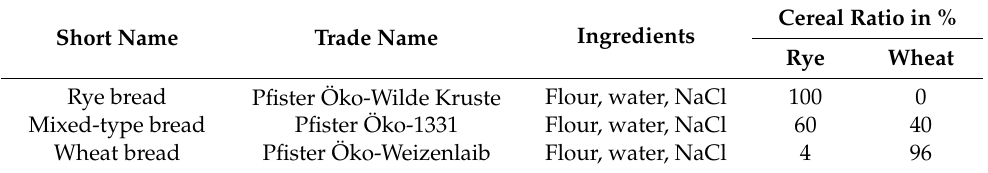
Table 1. Analyzed sourdough breads of Ludwig Stocker Hofpfisterei GmbH (Munich,